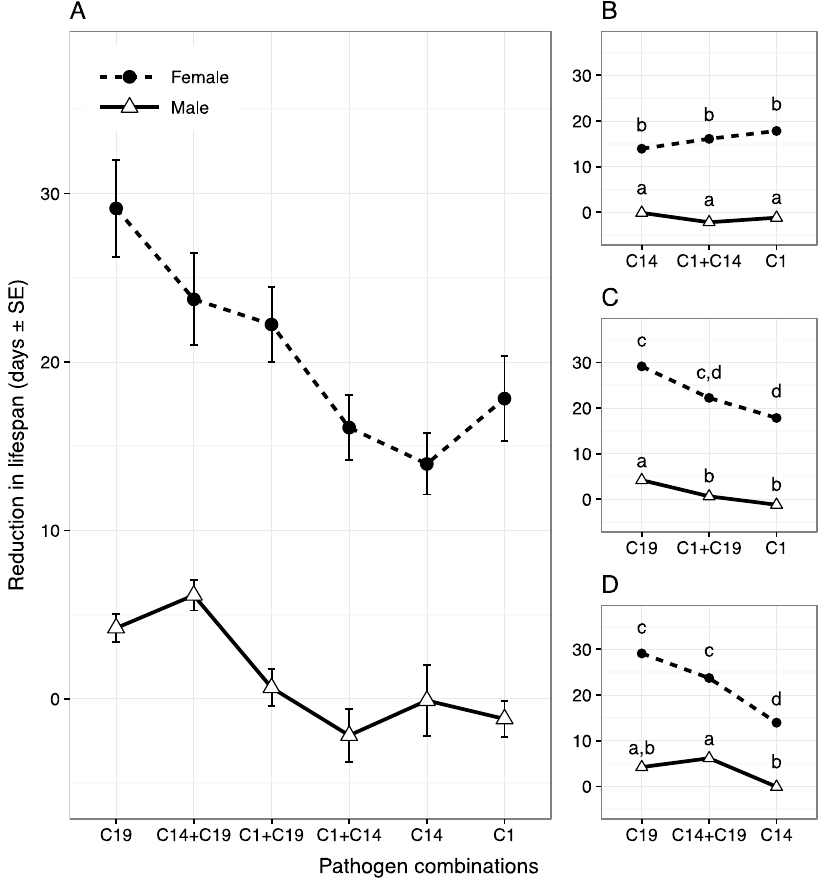
Figure 2. Relative reduction in host lifespan for all co-infection treatments. Pathogen combinations in panel A are ordered by spore loads in infected females (left to right, lowest to highest). Panels B to D show the same results subset by the specific co-infection combinations, with lower-case letters indicating significant groupings via post-hoc t-tests and Benjamini & Hochberg adjusted